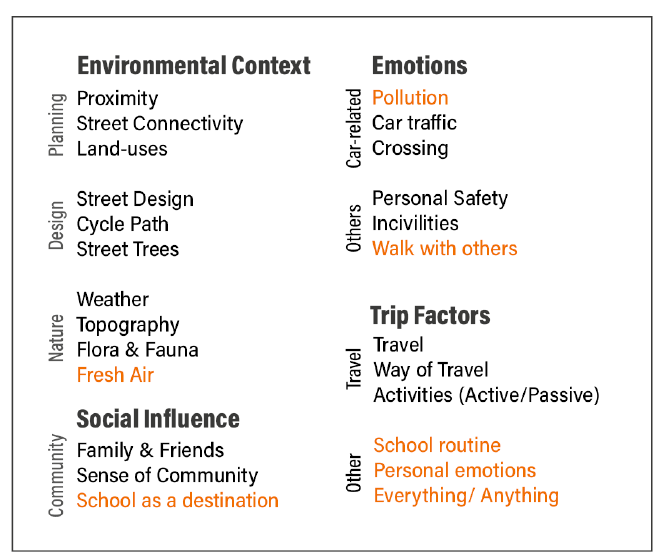
Figure 3. Typologies based on TDF: deductive and inductive (in orange) themes.